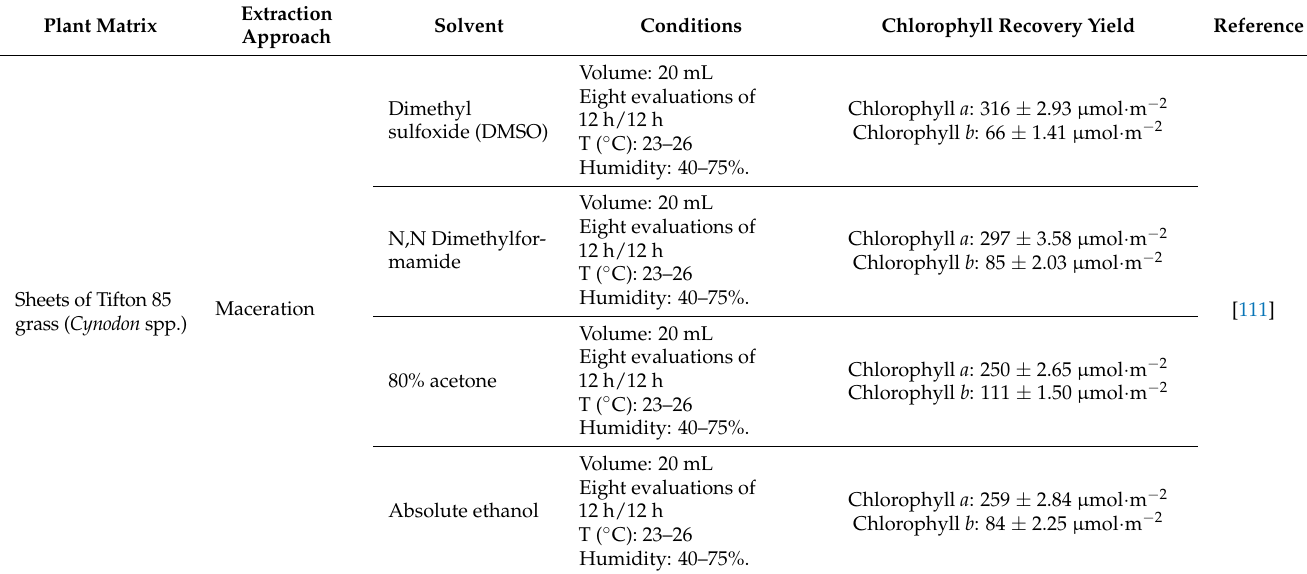
Table 3. Comparison of different methods used for chlorophyll extraction. Extraction Plant Matrix Approach